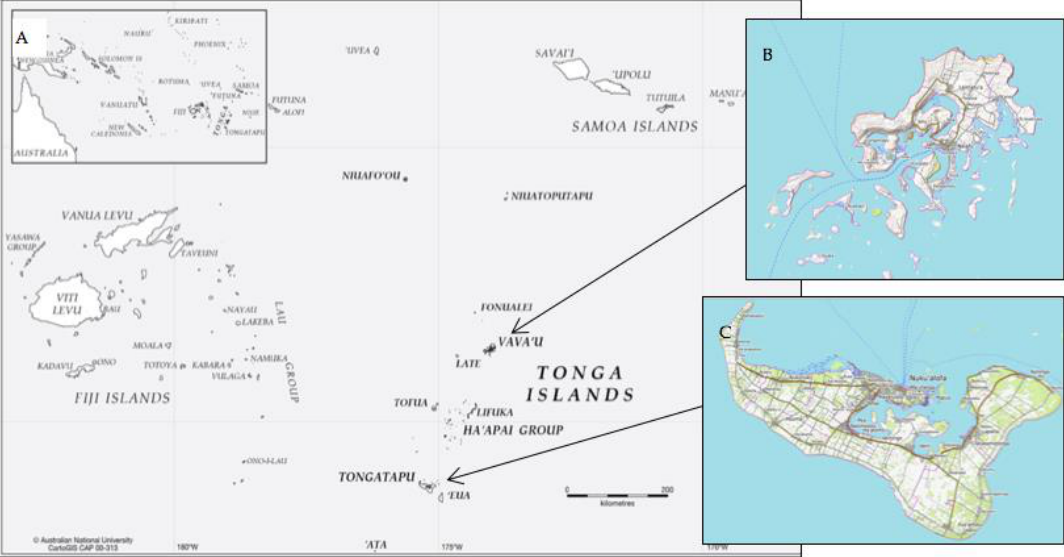
Figure 1. ( A ) Map of Tonga and the wider South Pacific region. ( B ) Map of Vava’u Island, Tonga. ( C ) Map of Tongatapu Island, Tonga. Map sources: ( A ) CartoGIS Services, College of Asia and the Pacific, The Australian National University 2019. ( B , C ) Opentopmap © .